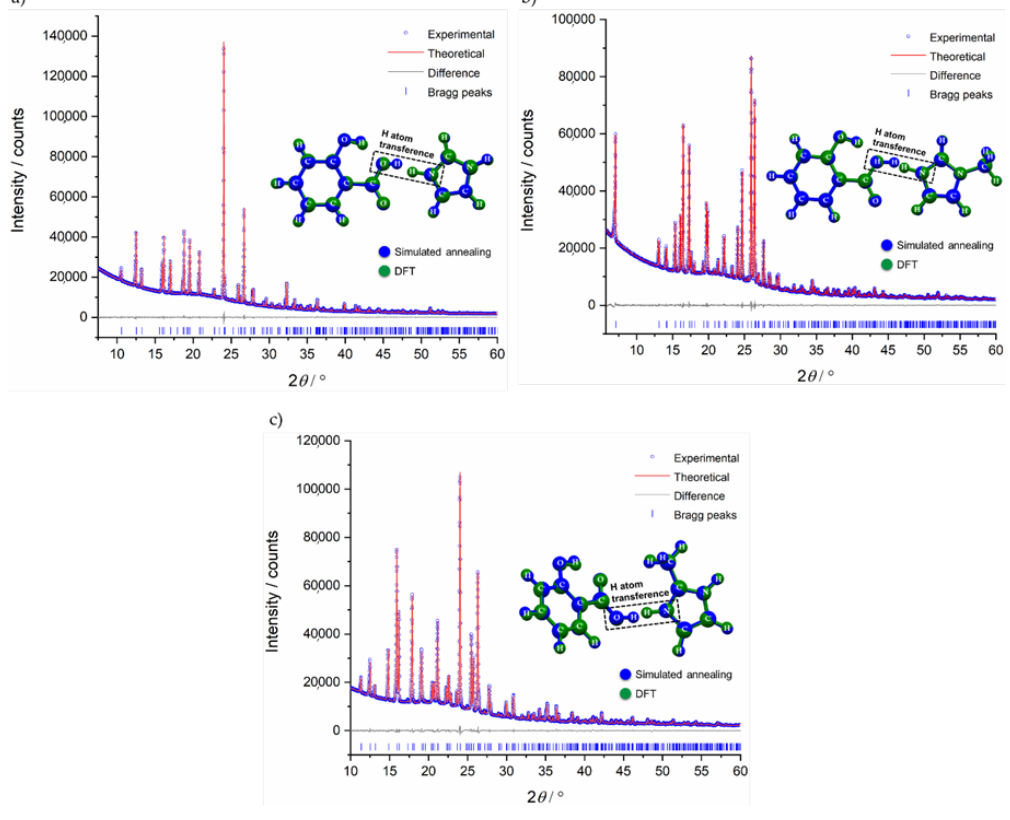
Figure 2. Rietveld refinement plot for ( a ) SA:IMI, ( b ) SA:1-MEIM and ( c ) SA:2-MEIM, displaying the experimental powder pattern (blue), the calculated powder pattern (red), the difference curve (grey), and the reflection positions (vertical blue dashes). A superposition of simulated annealing and density functional theory (DFT) structures is also depicted in blue and green, respectively. Molecules 2019 , 24 , x FOR PEER REVIEW